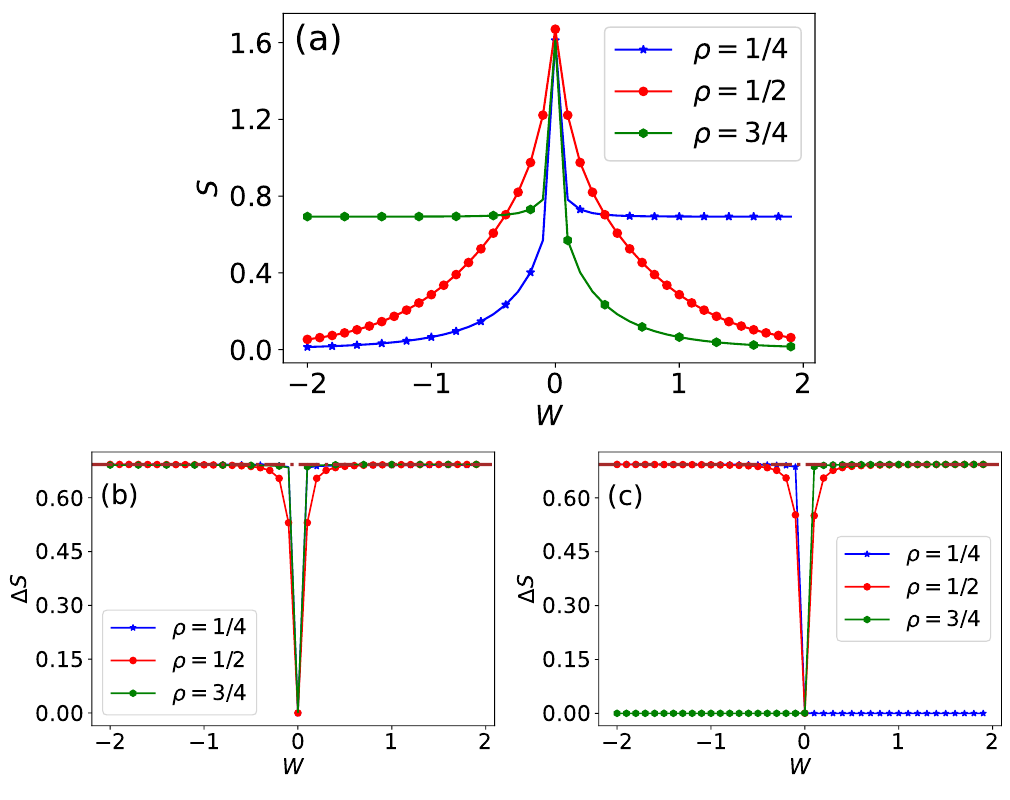
Figure 4: (a) Entanglement entropy as a function of W for filling fractions 1 / 4, 1 / 2 and 3 / 4 with OBC. (b,c) ∆ S as a function of W for PBC and OBC respectively. The other parameters are: N = 2000, t